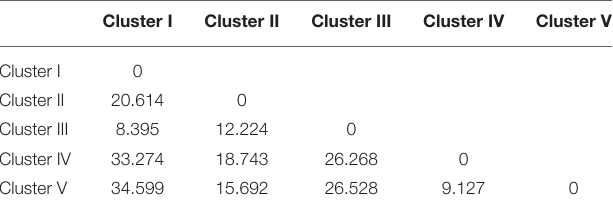
TABLE 8 | D2 statistics among different clusters regarding grain nutritional profile.